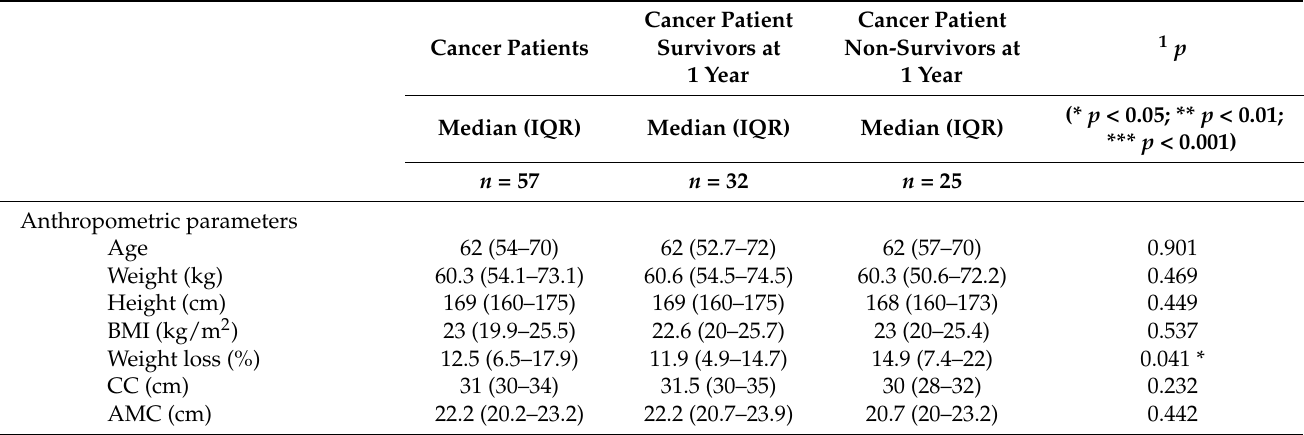
Table 2. Morphofunctional parameters of cancer patients related to survival and